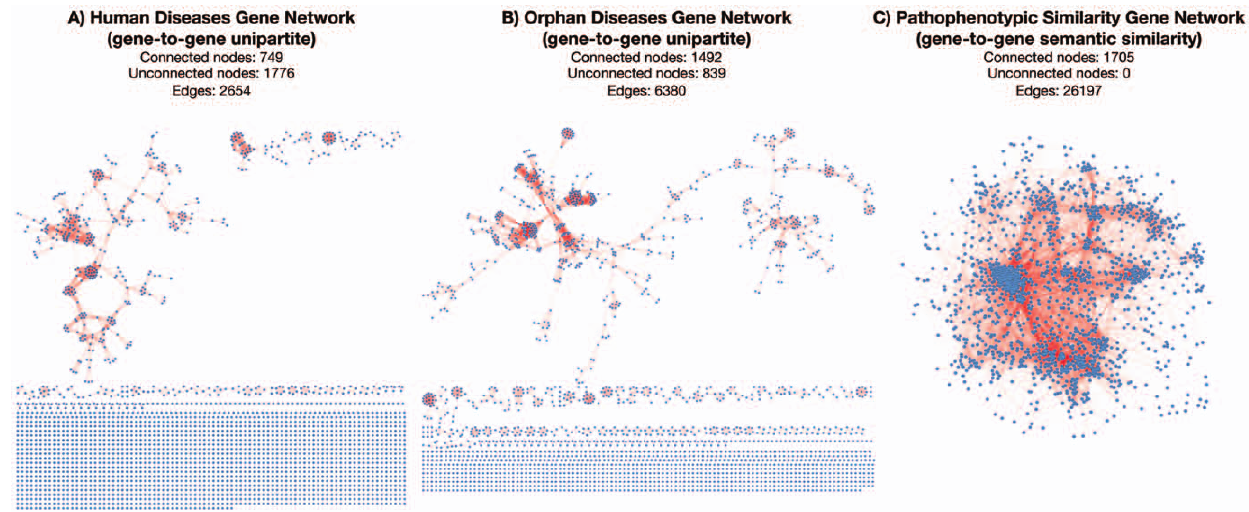
Figure 3. Unipartite gene-to-gene projections of the disease networks and the pathophenotypic similarity gene network. Human diseases genetic network (HDGN in panel A), Orphan diseases genetic network (ODGN in Panel B) and Human pathophenotype similarity gene network (PSGN in panel C). PSGN consists of one connected component (with a few unconnected genes), in contrast to HDGN and ODGN that show a great variety of isolated patterns of association. All unconnected genes (nodes) correspond to those uniquely associated with monogenic diseases, all of them were excluded in unipartite projections.